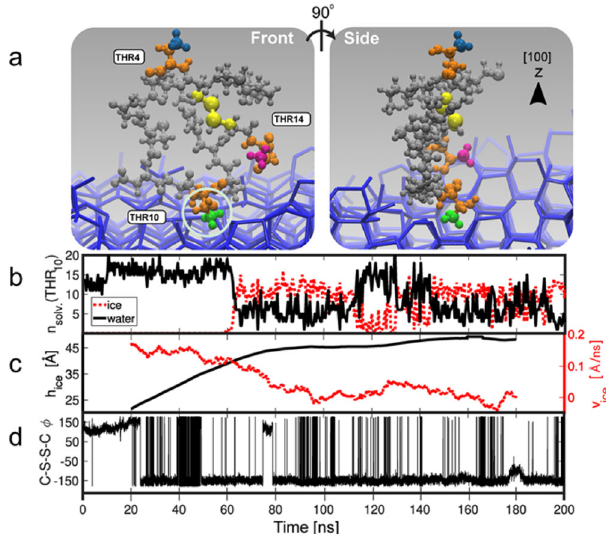
Fig. 8 Molecular dynamics simulations of peptide. a Snapshots of peptide 8 upon binding to ice from two different perspectives. The Thr residues are coloured orange, and their respective CH 3 groups are as follows; green is CH 3 on Thr10, blue is CH 3 on Thr4 and magenta is CH 3 on Thr14. The disul fi de bond torsional angle ( φ ) is coloured yellow. Adsorption of CH 3 to a growing ice front, the methyl fi ts into a pocket on the primary prismatic front (circled). b Representation of the amount of liquid (black line) and ice-like (red line) water in the solvation shell of Thr10. c Plot of ice growth in Angstroms and corresponding growth rate Angstrom/nanosecond. Adsorption of the peptide at 60ns, slows down the growth of the ice front in the z direction (black line) and reduces growth rate (dashed red line). d Analysis of the C – S – S – C torsional angle, φ , around the disul fi de bond throughout the simulation; Note that due to the use of a 5000 point moving average, the fi rst and last 20ns have been omitted. (Snapshots are from trajectory 18 in Supplementary Fig.